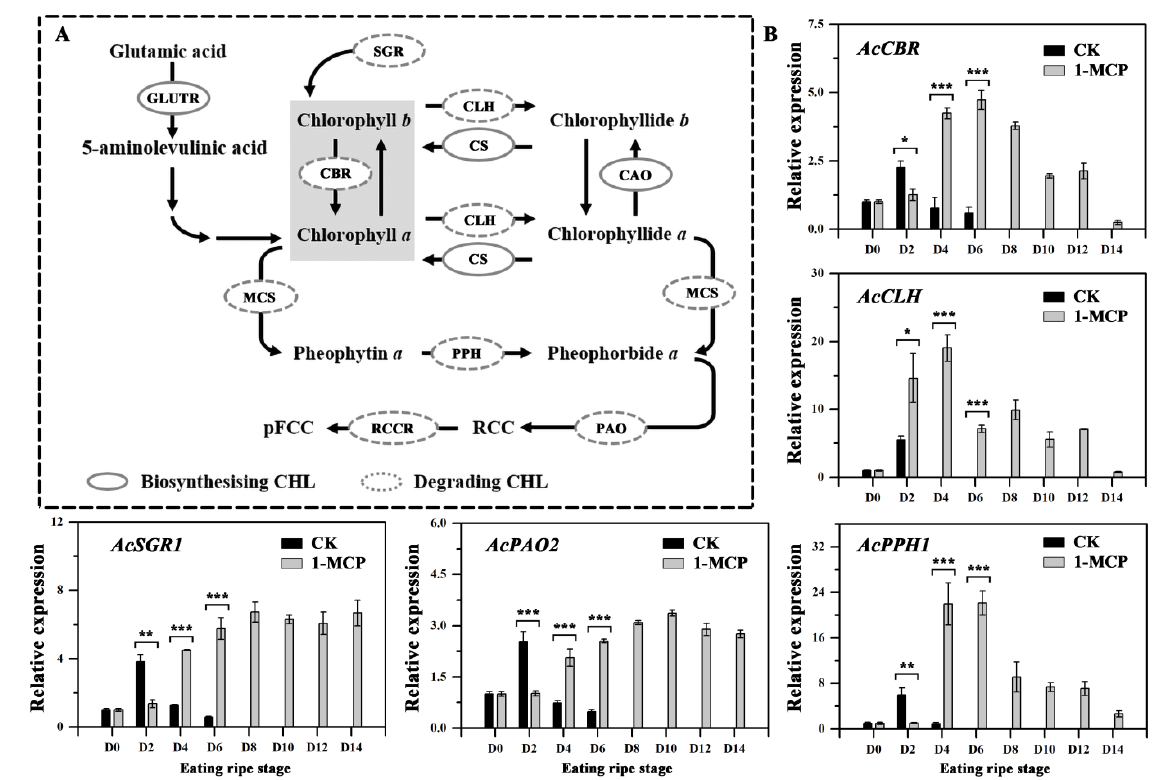
Figure 4. Expression profiles of genes involved in chlorophyll degradation in the flesh of kiwifruit. ( A ) Chlorophyll degradation pathway in kiwifruit. ( B ) Effect of 1-MCP on the expression profiles of chlorophyll degradation-related genes in the flesh during storage. The D0 stage was used as a reference (=1 relative expression) for each gene. Error bars show SE of the mean. Data were analyzed with Student’s t -test (* P < 0.05, ** P < 0.01, *** P < 0.001).